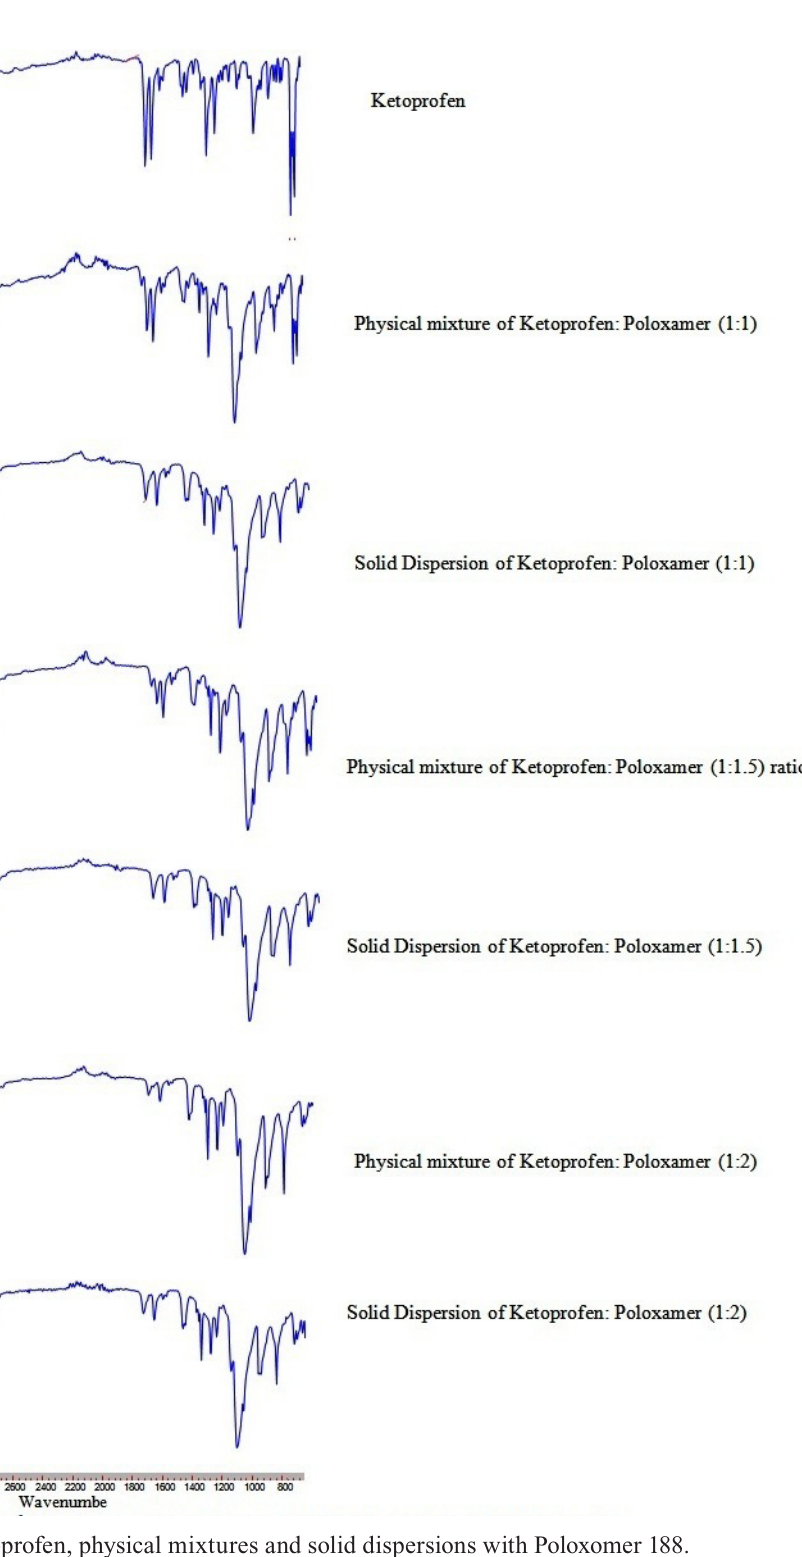
FIGURE 5 - ATR-FTIR of Ketoprofen, physical mixtures and solid dispersions with Poloxomer